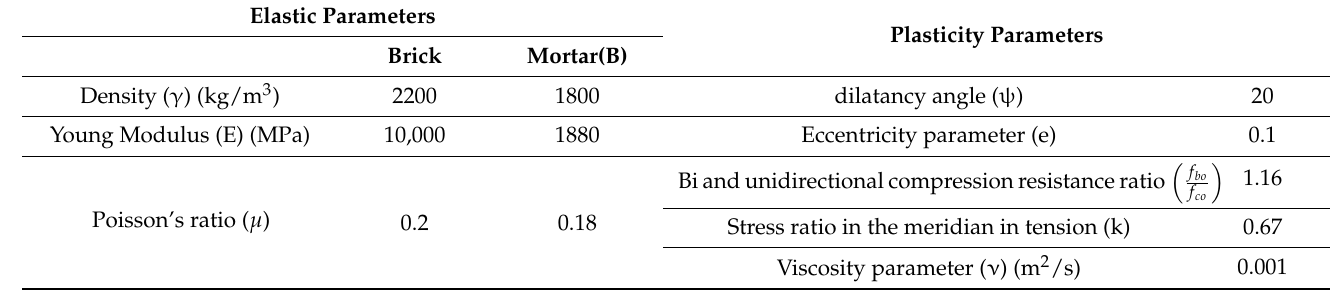
Table 6. Mechanical properties of the masonry unit and